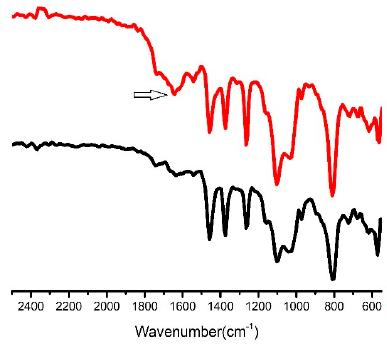
Figure 9. Infrared (IR) spectra of the original polypropylene (PP) surface (lower black line) and the PP surface with the plasma discharge (upper red line).